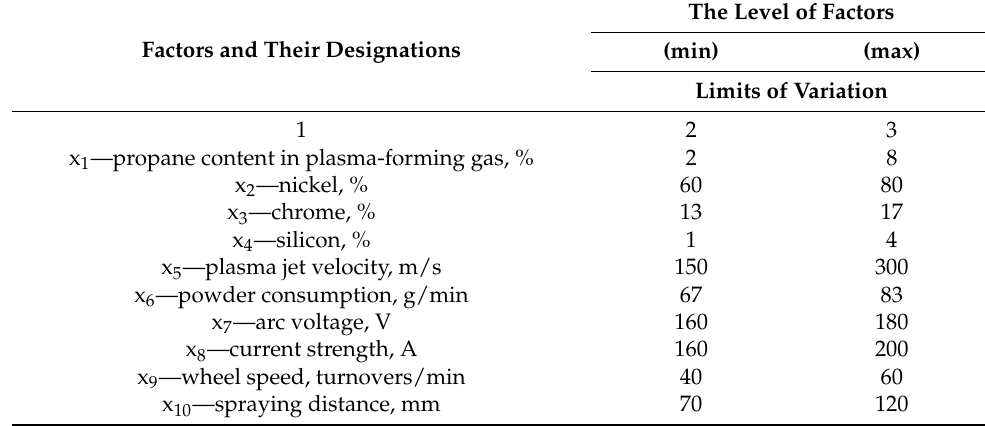
The Level of Factors (min) (max) Limits of Variation